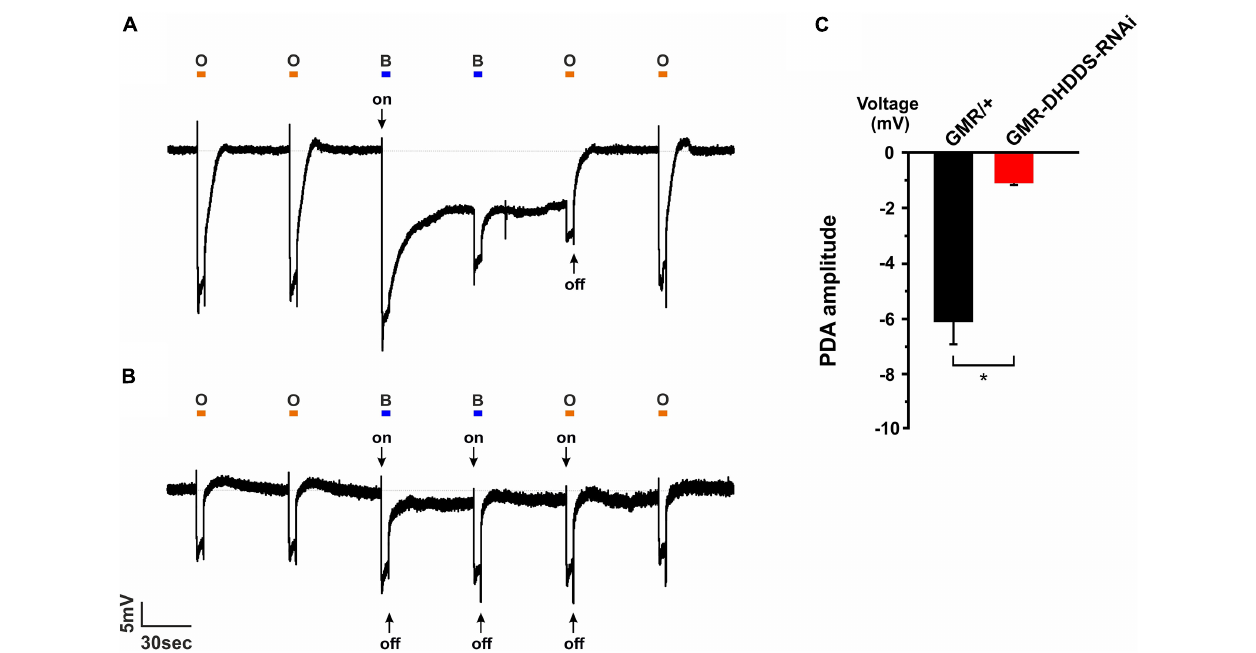
FIGURE 7 | Prolonged Depolarizing Afterpotential (PDA) revealed a highly reduced Rh1 rhodopsin level in GMR-DHDDS-RNAi flies in vivo. (A) A representative ERG response to intense blue and orange lights of a 21-days-old white-eyed control (GMR/+) fly. A similar ERG response was observed in a newly eclosed fly of the same strain, indicating the preservation of the structure and function of the control flies (not shown). The orange bars represent orange light pulses (O; Schott OG 590 edge filter), while the blue bars represent blue light pulses (B; Schott, BG 28 broad-band filter). The first blue light pulse induced a PDA in R1–6 photoreceptors by converting Rh1 rhodopsin to its dark stable state, metarhodopsin. An on transient is indicated (arrow). The following blue light-pulse elicited neither PDA nor on-and-off transients, but only an ERG response of the R7, 8 cells. An additional orange light-pulse converted metarhodopsin back to Rh1 rhodopsin and suppressed the PDA at the cessation of the light. The following orange light did not convert a net amount of photopigment and did not elicit a PDA. (B) An ERG response of a newly eclosed white-eyed GMR-DHDDS-RNAi fly showed a very short PDA, on-and-off transients (see arrows) and a smaller ERG response amplitude under an identical experimental paradigm, indicating a highly reduced Rh1 rhodopsin level. (C) A histogram comparing the PDA amplitude of 21-days-old white-eyed GMR/+ (black) and newly eclosed white-eyed GMR-DHDDS-RNAi flies (red). The baseline was set to 0mV, and the voltage was measured 55 seconds after the first blue light was turned off. Data is presented as mean ± standard error of the mean (SEM), n = 11. The difference between the two group was significant ( p ≤ 0.05, a two-tailed, unpaired student’s t